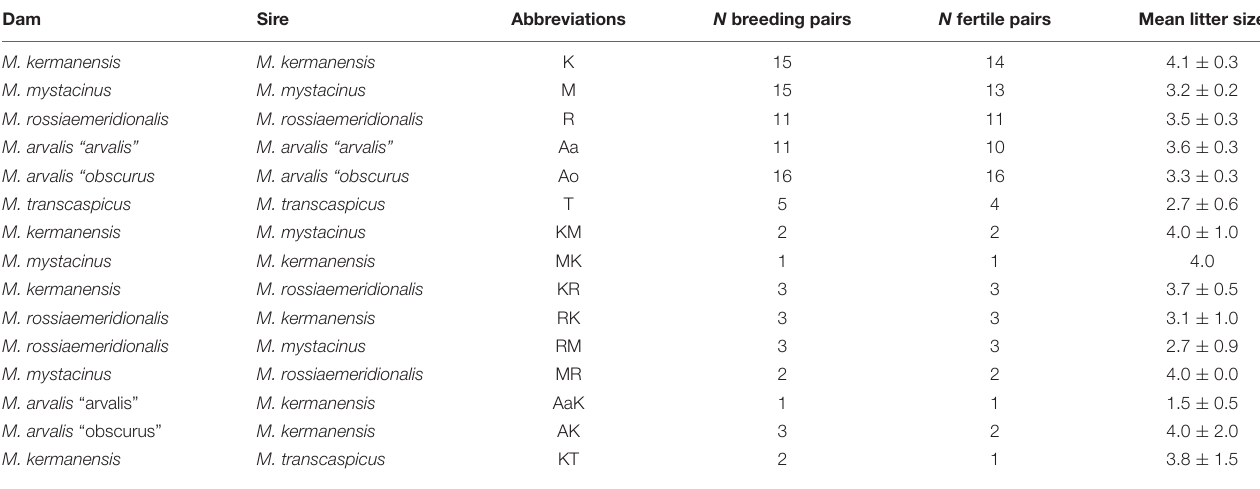
TABLE 2 | Reproductive performance of the voles of the subgenus Microtus in interspecies crosses. Dam Sire